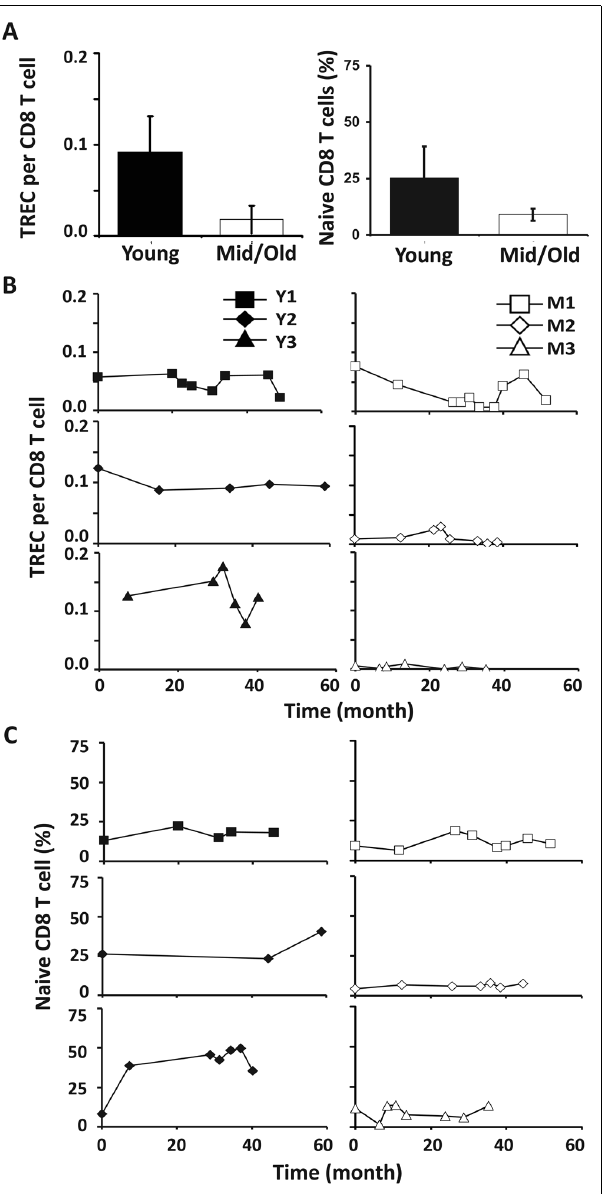
FIGURE 4 | CD8TREC levels were variable in both young and middle-aged donors. (A) TREC counts (left) and the percentages of naïve CD8T cells (right) are presented ( P < 0.05). (B) TREC counts in CD8T cells isolated from young (left panels) and middle-aged (right panels) donors are shown. (C) Naïve (CD45RA + and CD62L + or CCR7 + ) CD8T cells were examined. PBMC were counterstained with CD8 and CD45RA and CD62L or CCR7 and examined by FACS analysis.